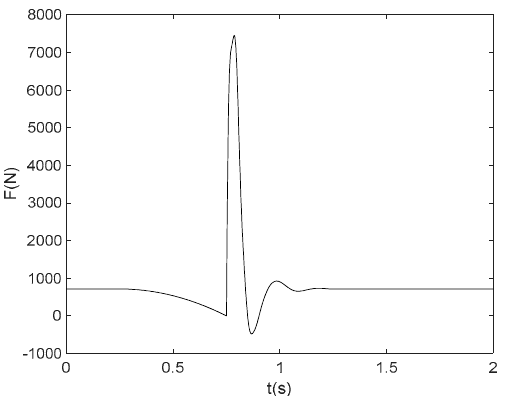
Figure 16. Floor force during the process of human falling (weight 71 kg).